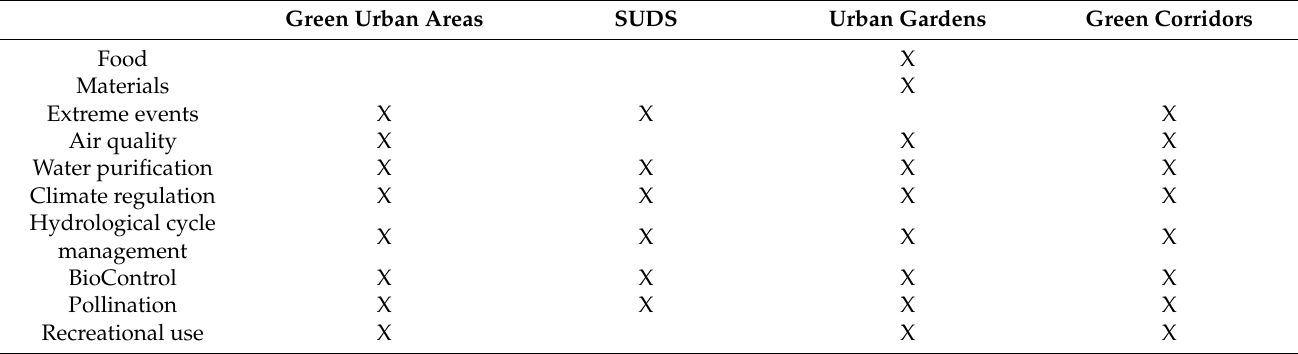
Table 2. Green Infrastructure present in the study area and its associated ecosystem services (based on [43]). Green Urban